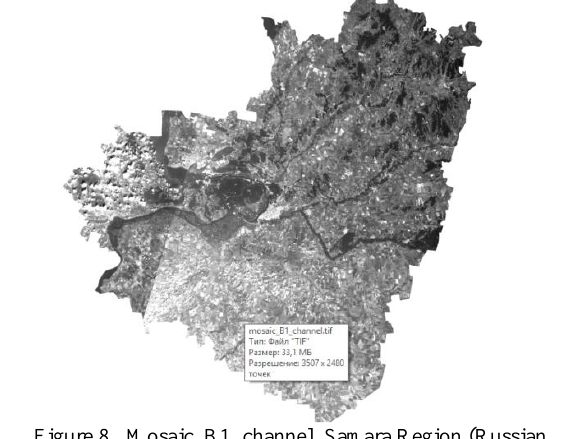
Figure 8. Mosaic_B1_channel. Samara Region